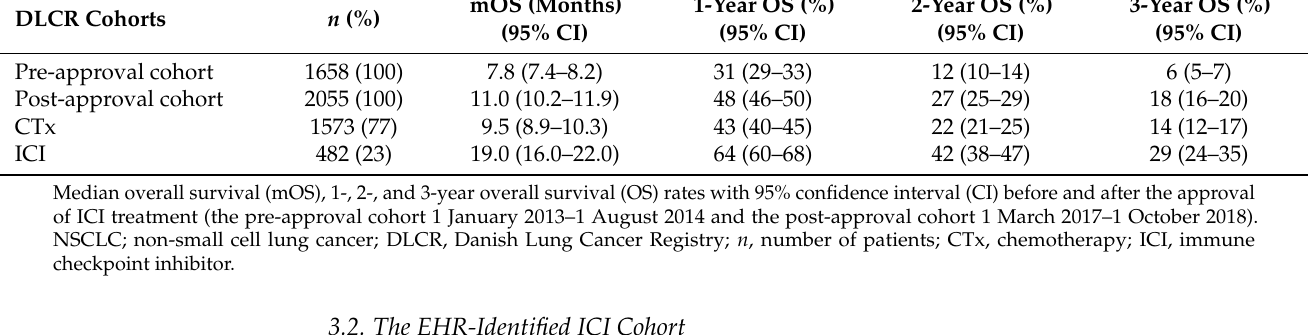
Table 1. Survival of patients with advanced NSCLC treated with systemic antineoplastic treatment before and after the introduction of ICIs.